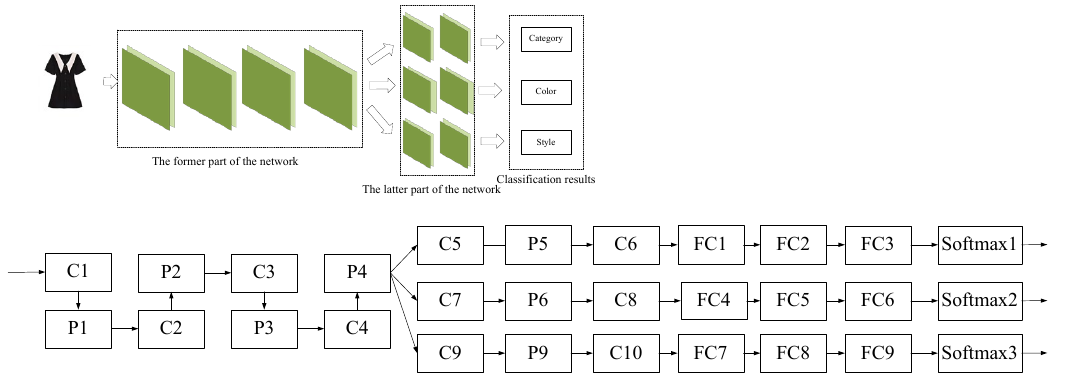
Figure 3. The architecture of the MCNN.